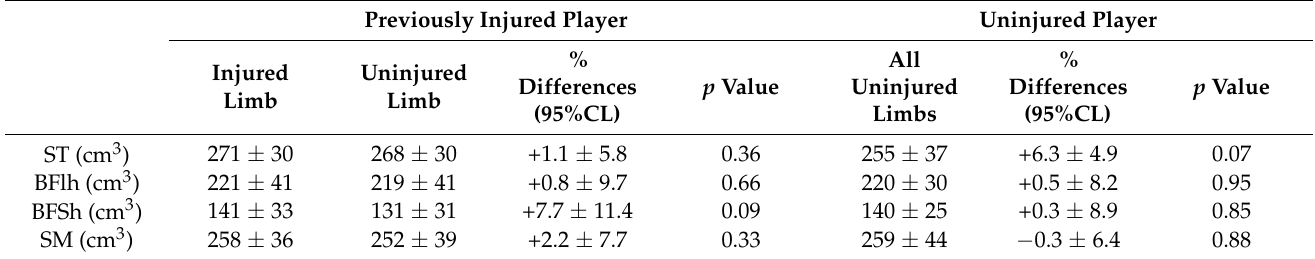
Table 3. Comparison of muscle volume for the semitendinosus (ST), biceps femoris long head (BFlh), biceps femoris short head (BFSh), and semimembranosus (SM) muscles assessed with magnetic resonance image (MRI) between the injured players (i.e., players with a history of a previous injury within the last two competitive seasons) and all uninjured limbs in the uninjured players. Previously Injured Player Injured